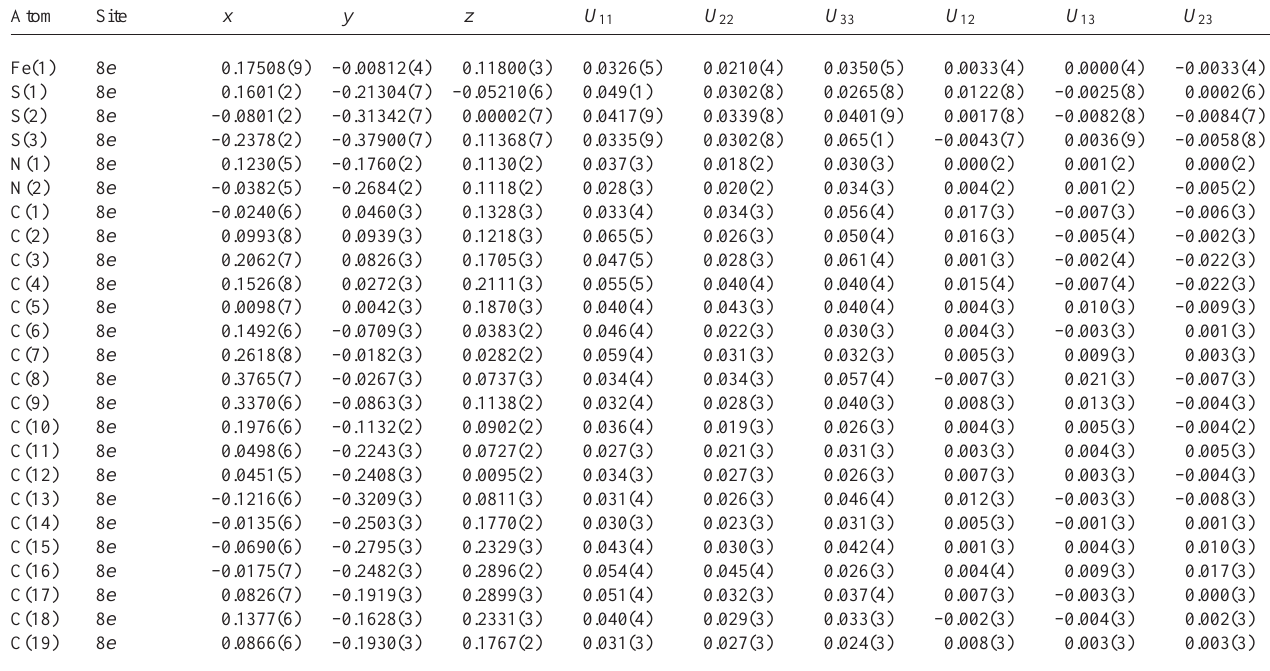
Table 3. Atomic coordinates and displacement parameters (in Å 2 ) .